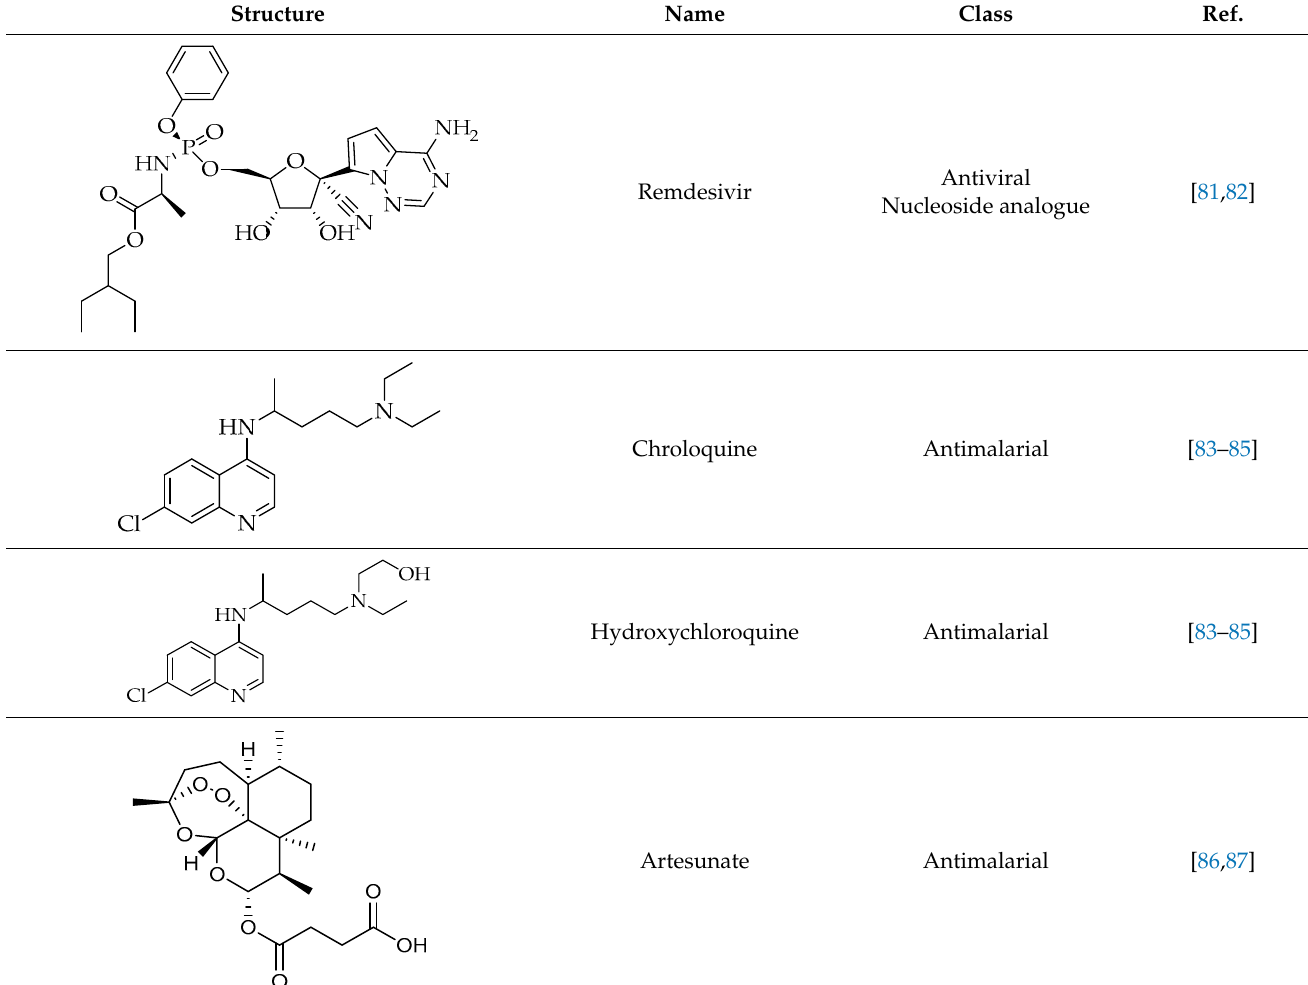
Table 3. Structure of current drugs used for COVID-19 treatment.